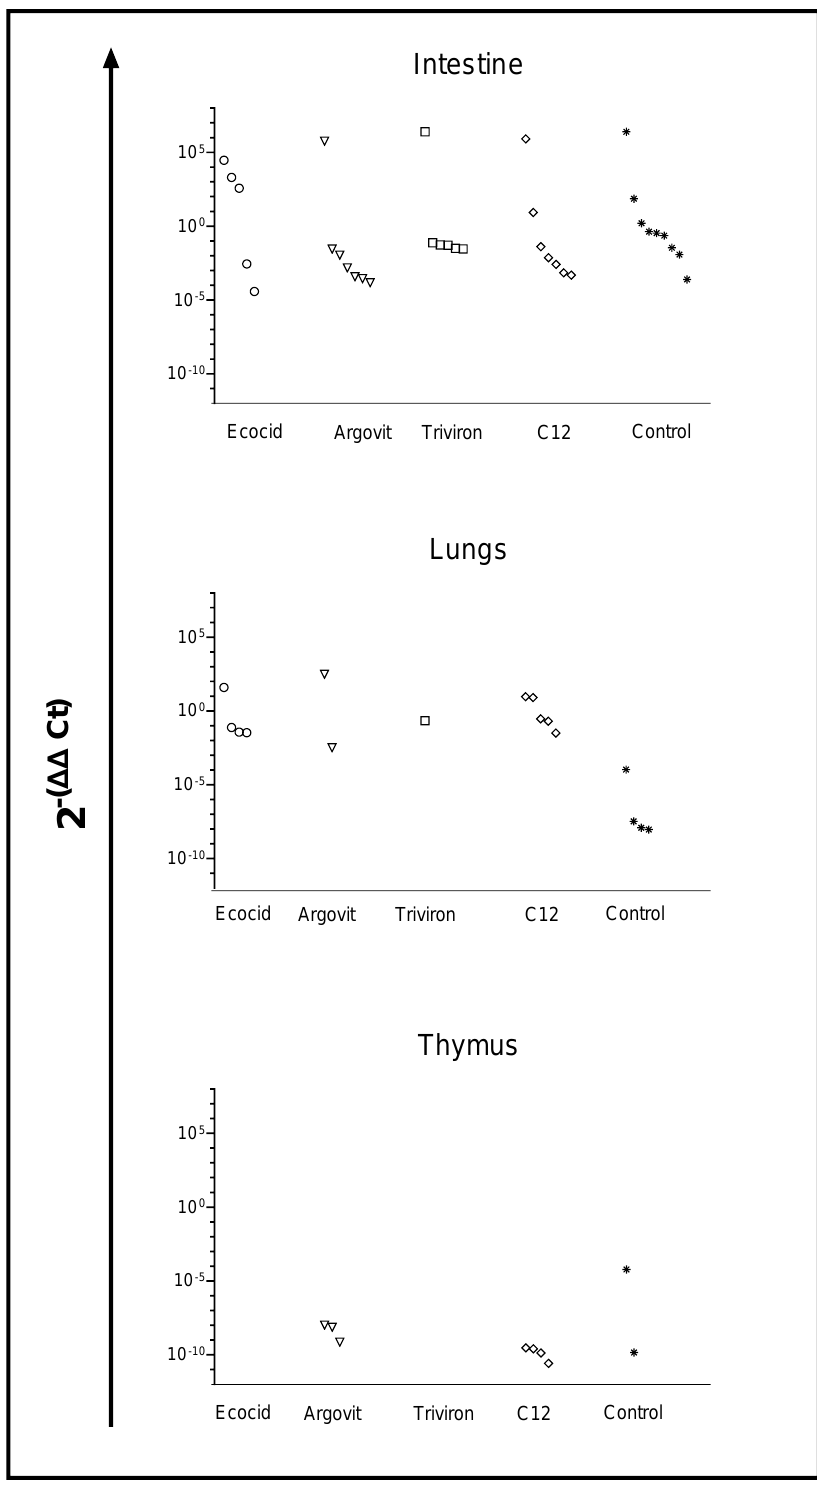
Figure 4. The concentration of IBV in the intestine, lungs, and thymus in chickens of the experimental and control groups. Data are presented in 2 − ( ∆∆ Ct) units, which reflect the concentration of IBV from chickens treated with Ecocid (O), Argovit ( ∇ ), Trivirion ( (cid:3) ), C12 ( ♦ ), Control (*). Every group contains data for 13